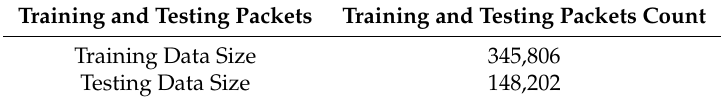
Table 2. Training and testing samples for KDD99.